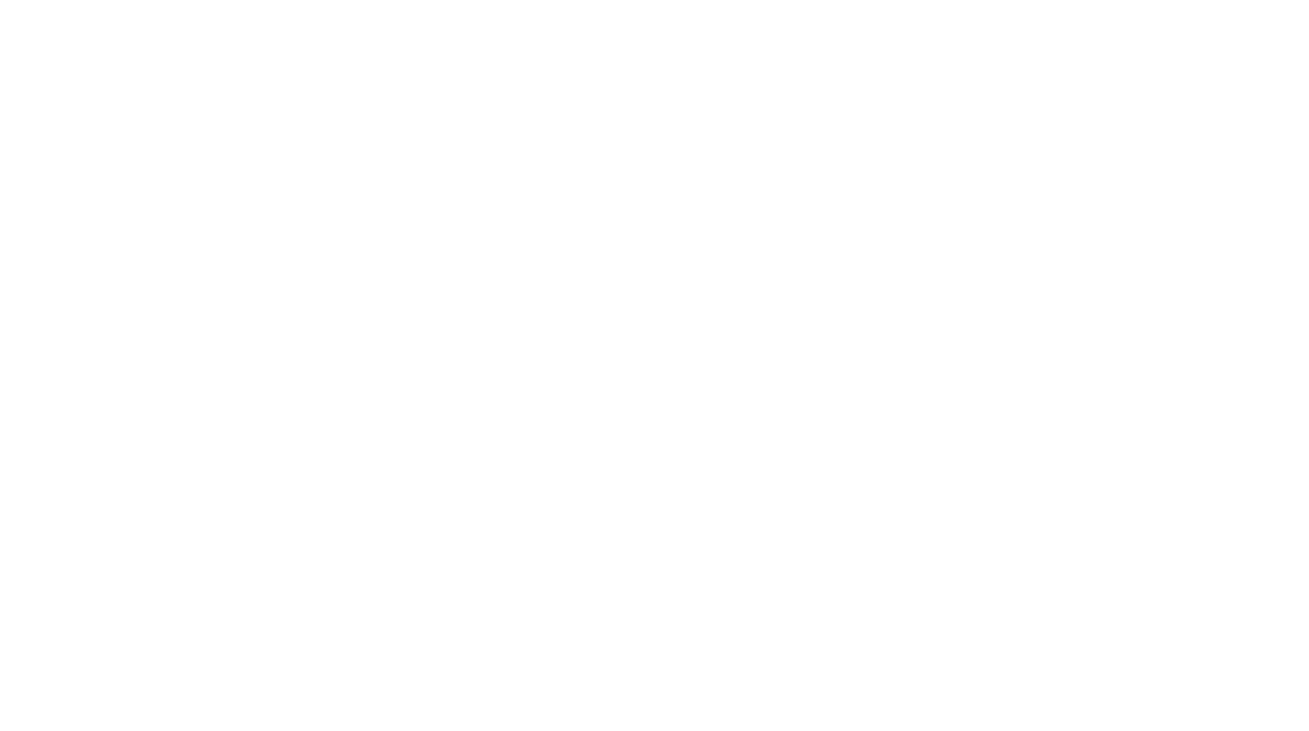
Frontiers in Plant Science |